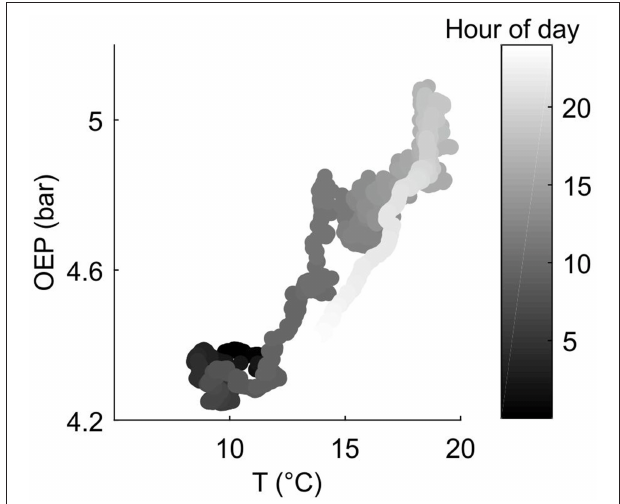
FIGURE 1 | Example on the relation between measured oleoresin exudation pressure (OEP) at the top part of Tree 1 stem (Scots pine) and ambient temperature at SMEAR II station on 9.6.2017.